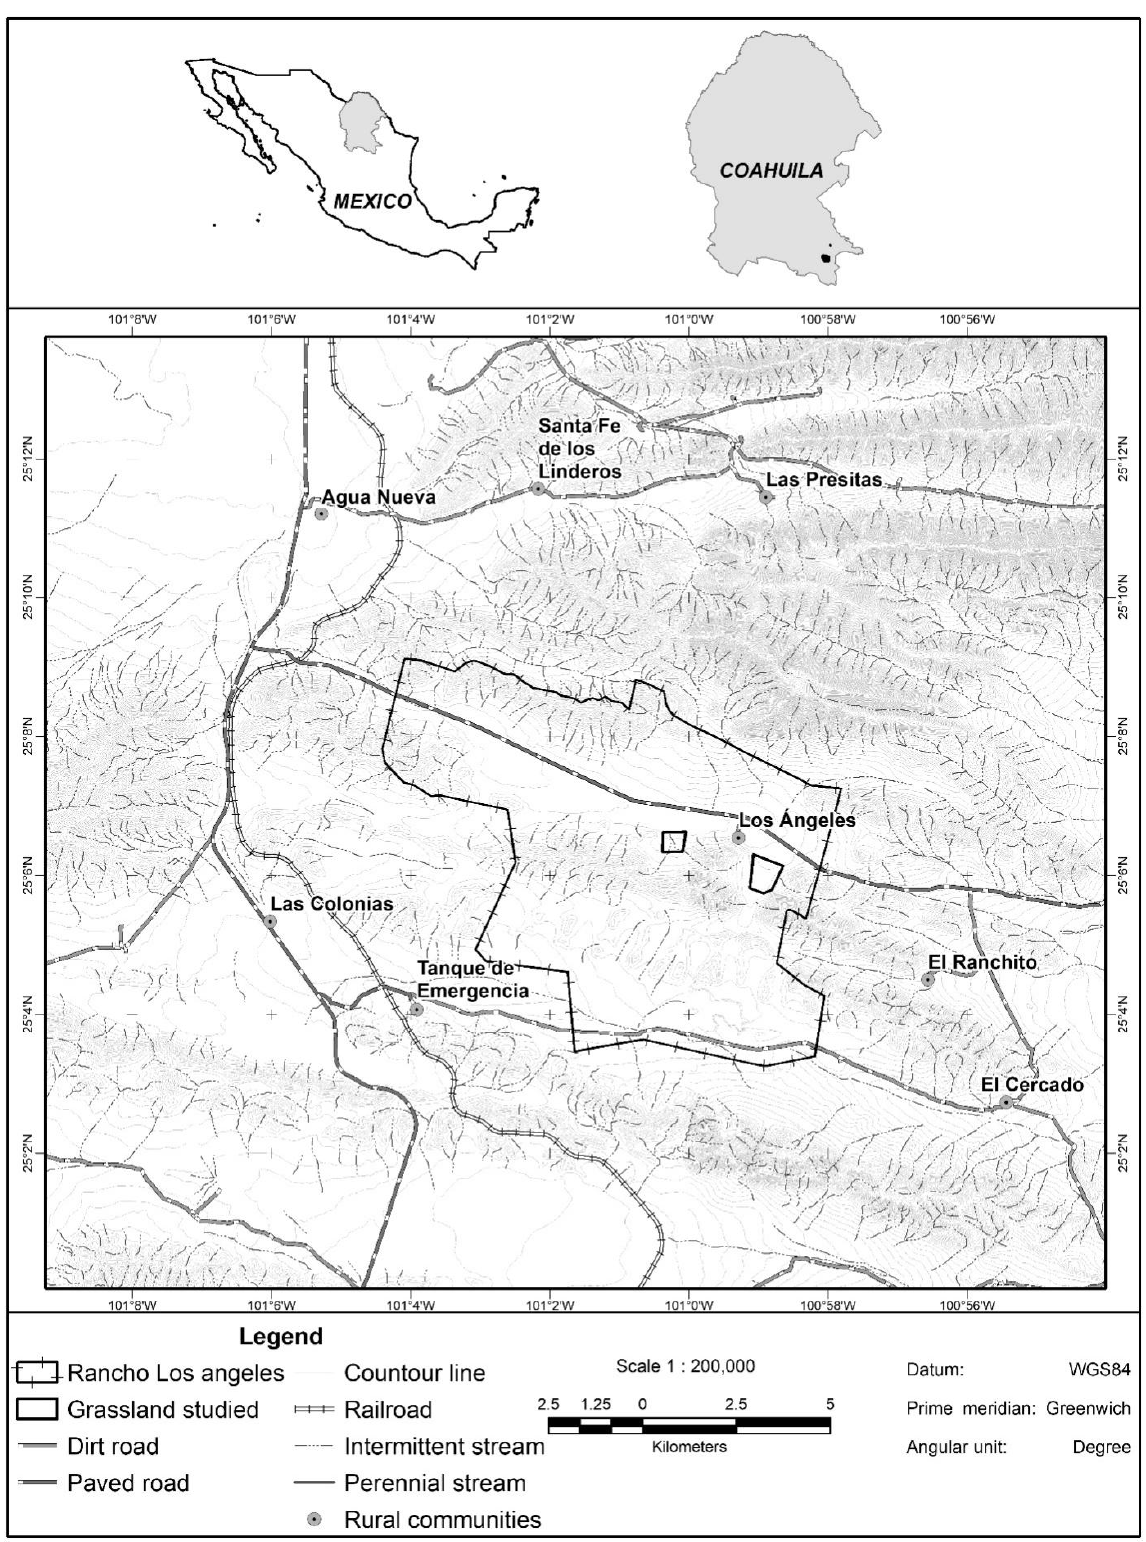
Figure 1. Location of the study area Rancho Los Angeles (enclosed by the thin black line polygon) in northern Mexico (25 ◦ N). The two blocks of this study inside Rancho Los Angeles are enclosed in the two polygons in thick black lines. Experimental plots were established in two agricultural areas abandoned in 2009—one with a surface area of 40 and the other 60 ha. After the suppression of the